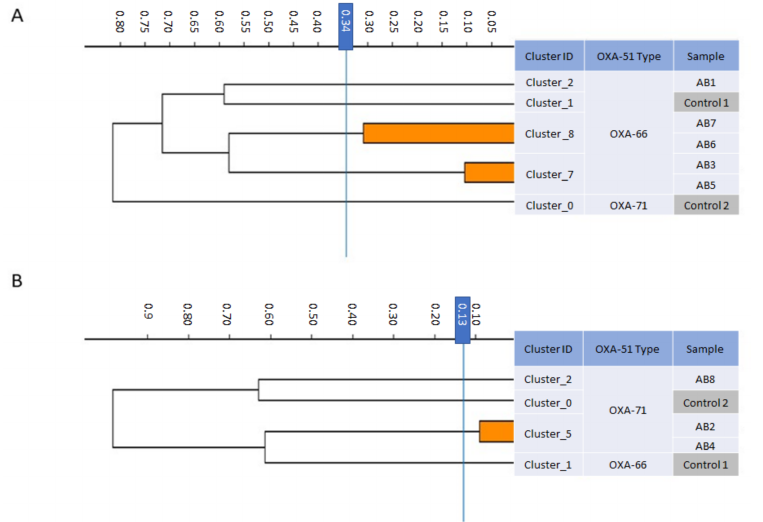
Figure 3. Dendrogram obtained by FT-IR biotyping of colistin-dependent A. baumannii isolates ( n = 8). The blue line represents the cutoff value. Clusters composed of two of more isolates are shaded orange. ( A ) OXA-66-type strains. ( B ) OXA-71-type strains. Controls–unrelated strains from laboratory collection.